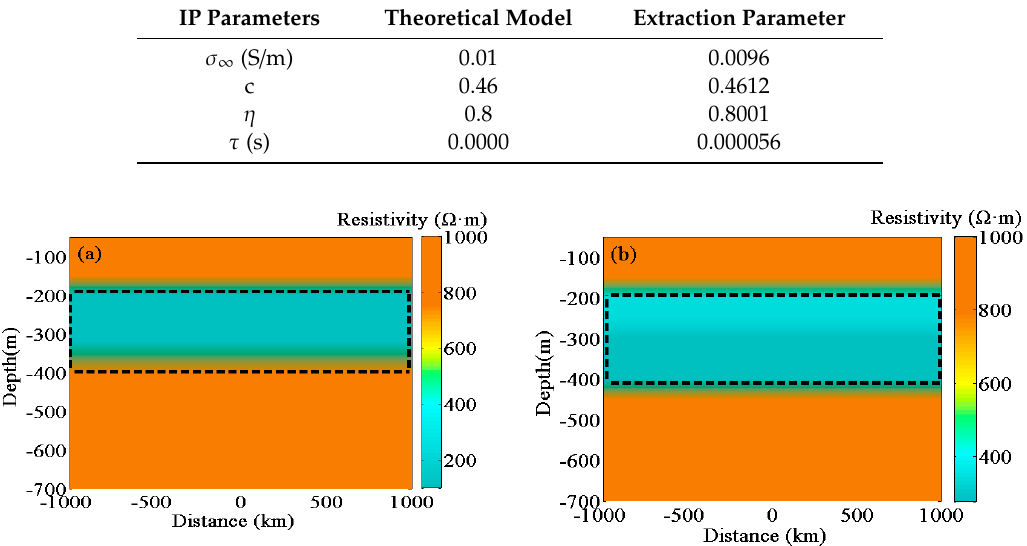
Figure 17. Porous polarized media depth imaging (( a ) traditional skin depth formula; ( b ) generalized polarized media skin depth formula).